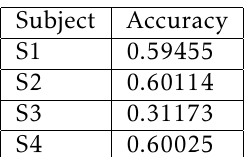
Table 1. Benchmark results for the activity recognition model utilising a single hidden layer NN and 100% of labelled